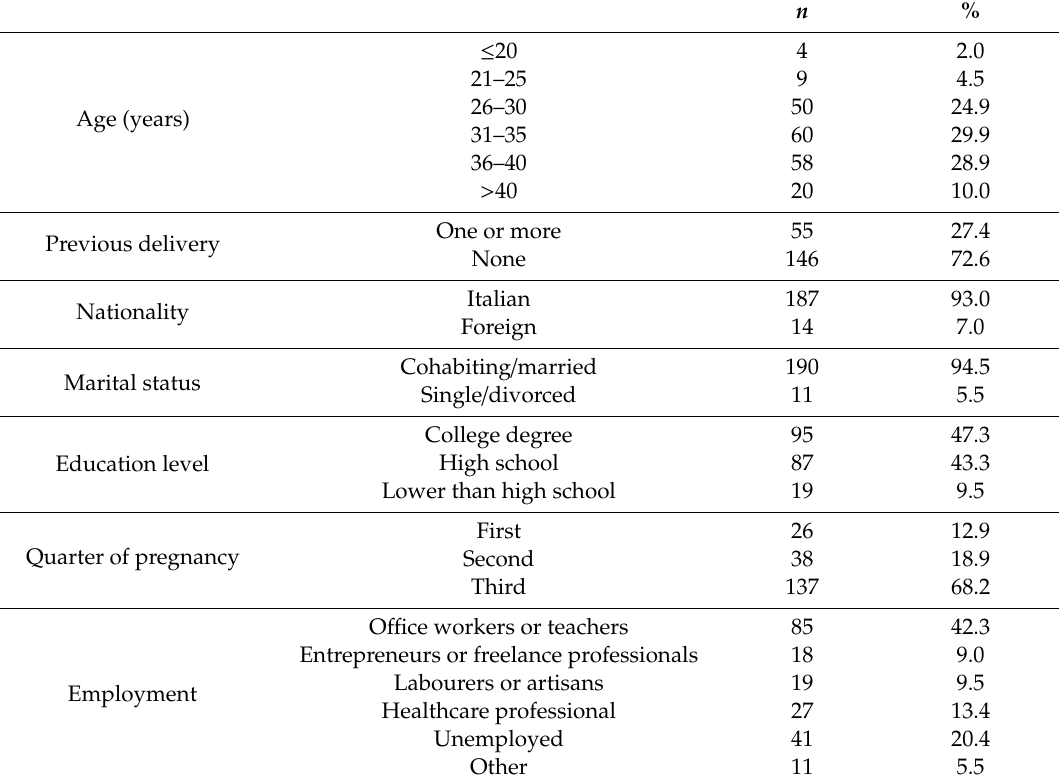
Table 1. Socio-demographic characteristics of the